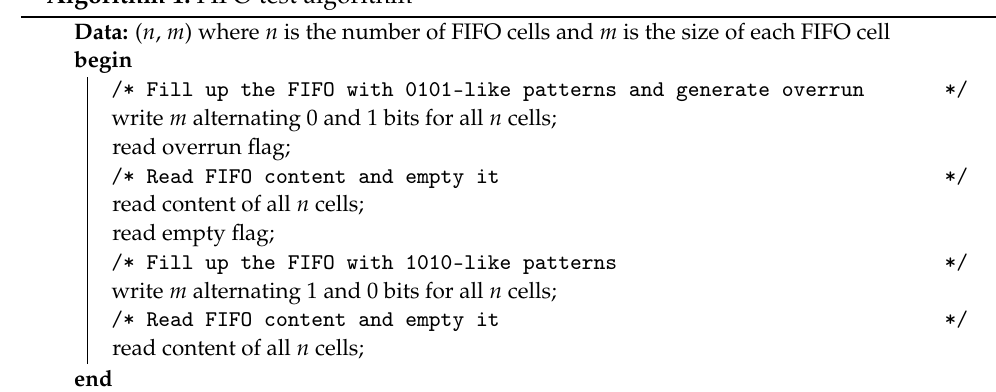
Algorithm 1: FIFO test